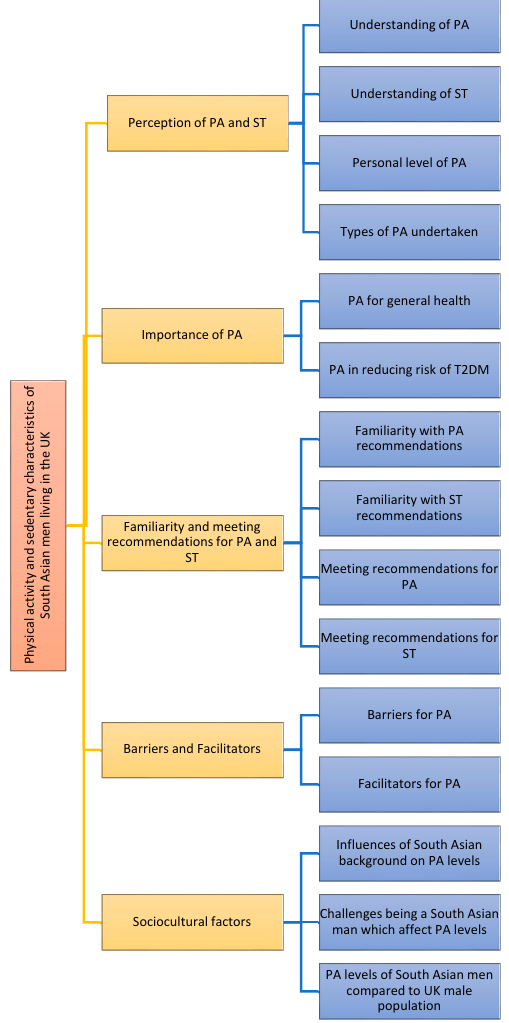
Figure 2. Diagram showing the final coding matrix identifying the key factors identified as influencing physical activity and sedentary time in the 31 participants who participated in the semi-structured qualitative interviews. T2DM: Type 2 Diabetes